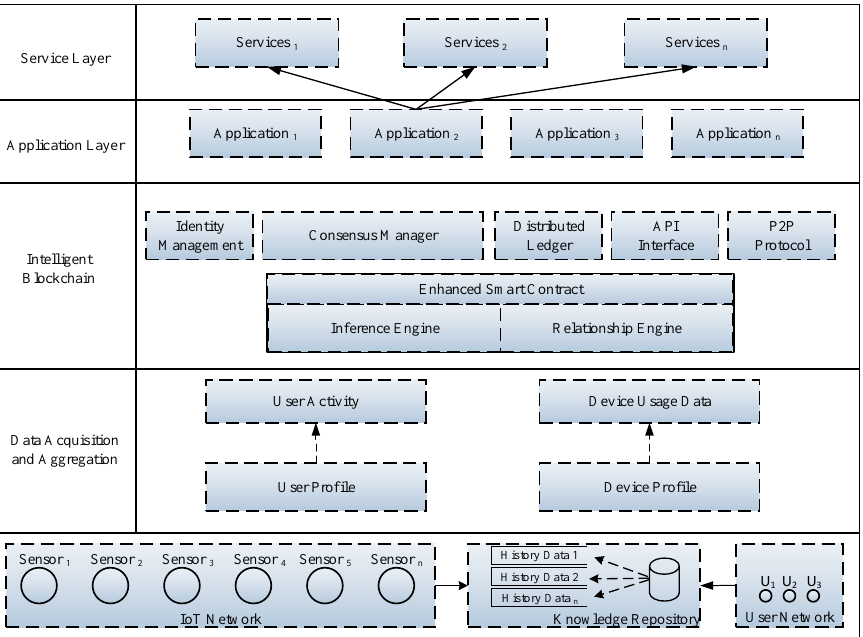
Figure 2. Proposed intelligent service architecture based on enhanced smart contract with relationship and inference engine in IoT